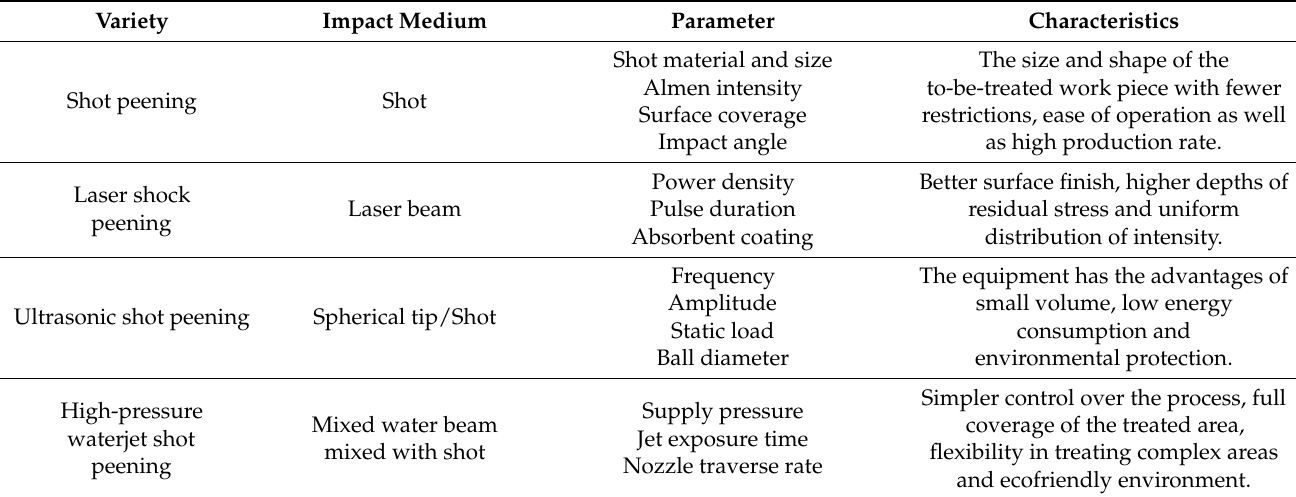
Table 1. Different shot peening techniques and their characteristics.